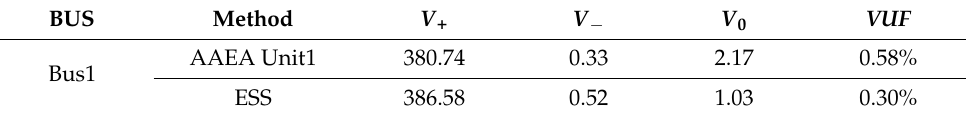
Table 1. Comparative Results for the two